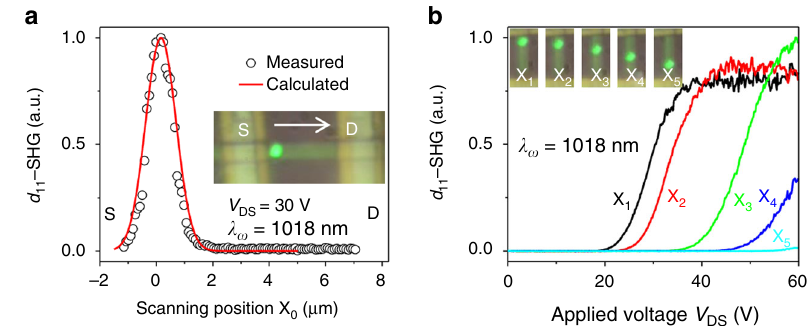
Fig. 3 Laser position dependence of d 11 -SHG signal along the CdS nanobelt device. a d 11 -SHG signal scanned over the entire nanobelt from the source to drain electrodes at V DS = 30 V. The calculated curve was obtained using equation 1 and Supplementary Equation 19 in Supplementary Note 4. b Position dependence of voltage-controlled SHG. Inset: optical images of the nanobelt device when the FW was incident at different regions at X 1 , X 2 , X 3 , X 4 , and X 5 from source to